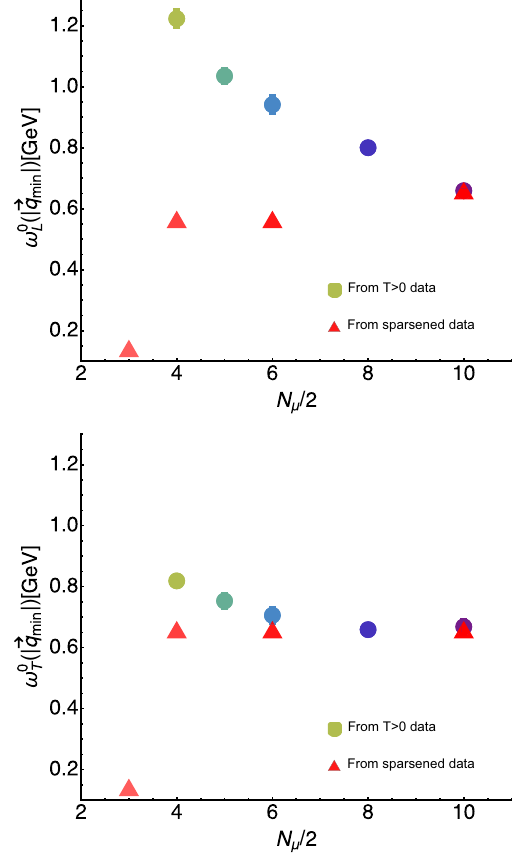
Fig. 11 Comparison of the finite-temperature spectral reconstructions to those based on sparsened low-temperature longitudinal (top row) and transversal (bottom row) correlators at β = 2 . 10. In the left column we show the reconstructions at the lowest T = 0 . 152 GeV, an interme- diate T = 0 . 305 GeV and a high T = 0 . 508 GeV as colored solid lines together with the reconstructions based on the sparsened data at = 20 , 10 , 5 as gray dashed lines. At T = 0 . 305 GeV we find that N q 4 the actual T > 0 reconstruction (green) shows a clear sign that the